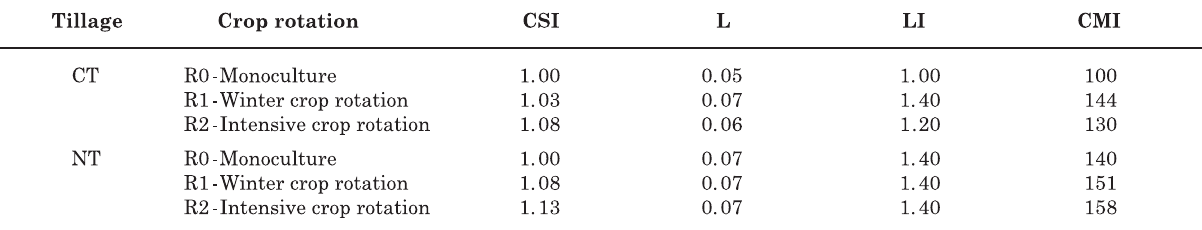
Table 4. Carbon stock index (CSI), C lability (L), C lability index (LI), and C management index (CMI) of the 0–0.30 m layer of a subtropical Oxisol subjected to conventional tillage (CT) and no tillage (NT) under three cropping systems (R0=wheat/soybean, R1=wheat/soybean/black oat/soybean, R2=black